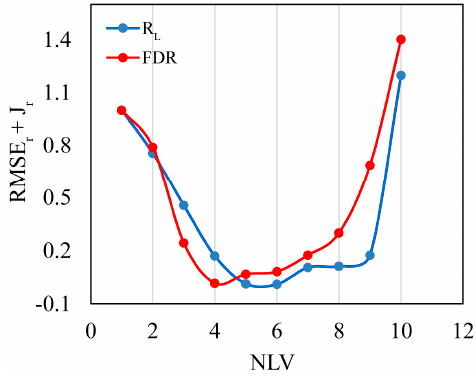
Figure 10. Results for the RMSE r + J r when using different number of latent variables (NLV). Because of the iterative stepwise elimination function, we selected the optimal wavebands using ISE-PLS for both R L and FDR datasets based on the lowest RMSE for validation, as shown in Figure 11b,d. Selected wavebands for R L ranged from 495 to 496 nm [43], 589 to 593 nm [44], and 660 to 667 nm [45], which had been proven related to phytoplankton absorption, 544 to 549 nm [43], and 689 to 696 nm [32], which indicated relationship with Chl- a fluorescence, and 730 nm which is also sometimes used for Chl- a retrieval [45]. We selected a total of 30 (6%) informative wavebands from all 501 wavebands. And for FDR, we selected 10 (2%) informative wavebands from all 501 wavebands.